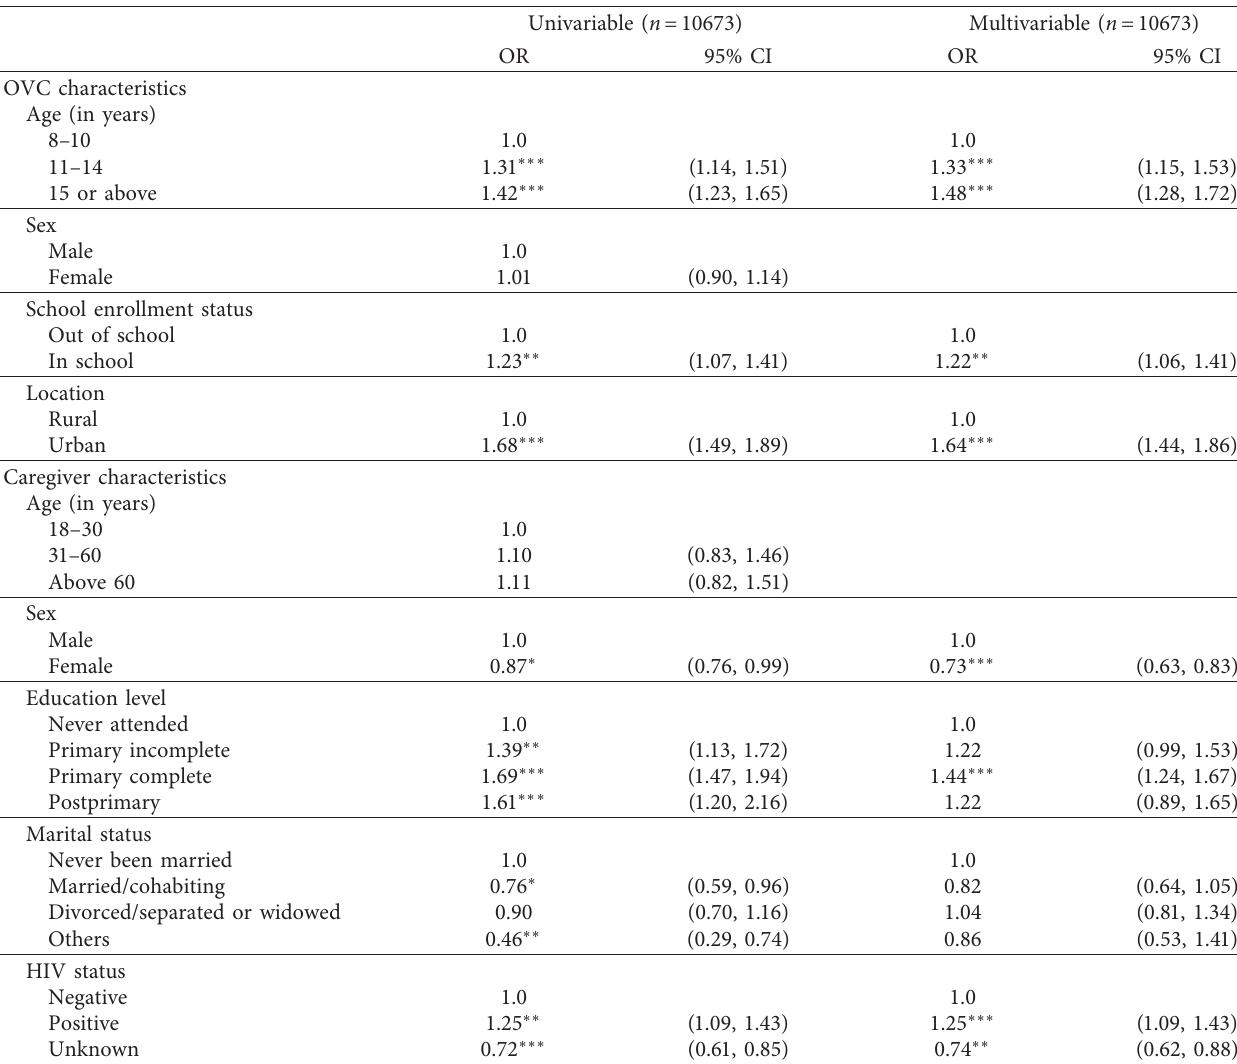
Table 3: GEE results of OVC and caregiver characteristics associated with disclosure status of